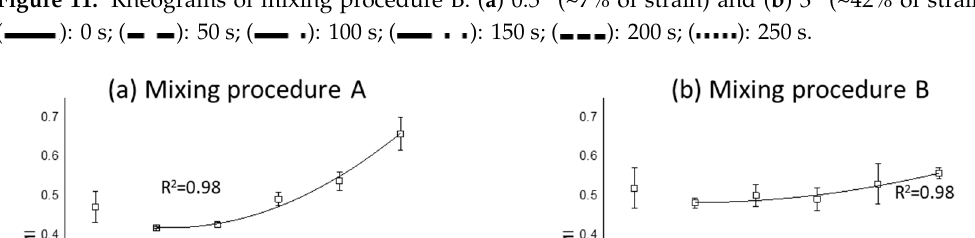
Figure 2. Mixing fingerprints of mixing procedure B; (